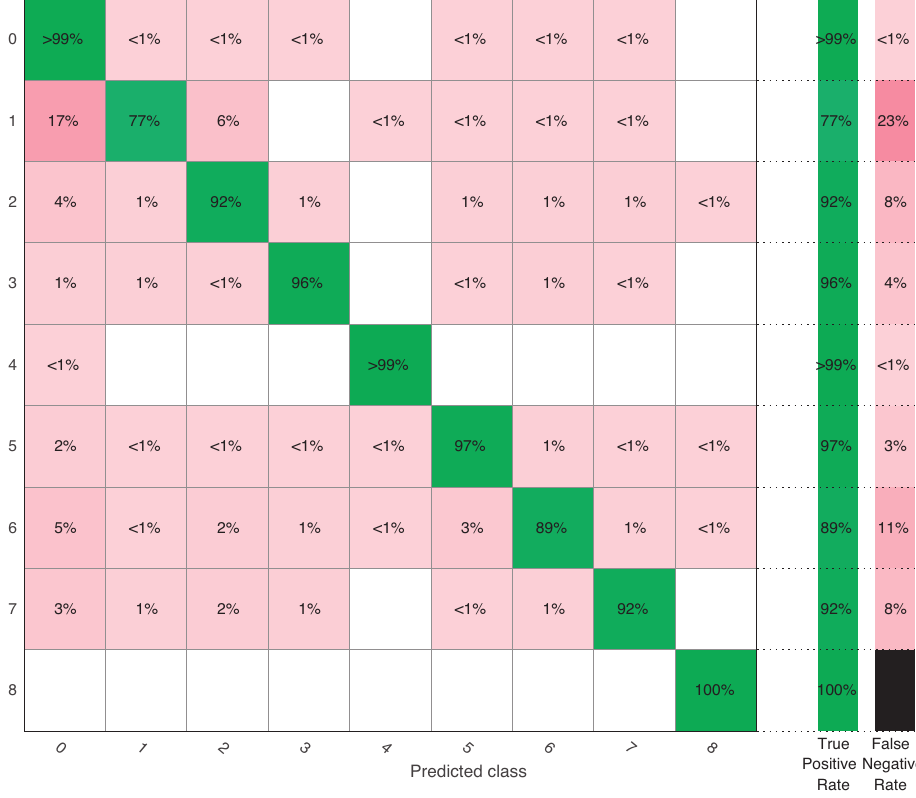
Figure 6. Confusion matrix when J = 3.